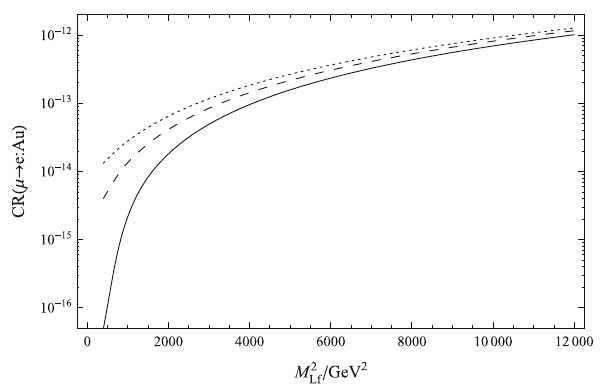
Fig. 15 With μ = 0 . 4 ( 0 . 5 , 0 . 6 ) TeV, the μ − e conversion rates in Au nuclei versus parameter M 2 are plotted by the dotted, dashed and solid Lf lines respectively